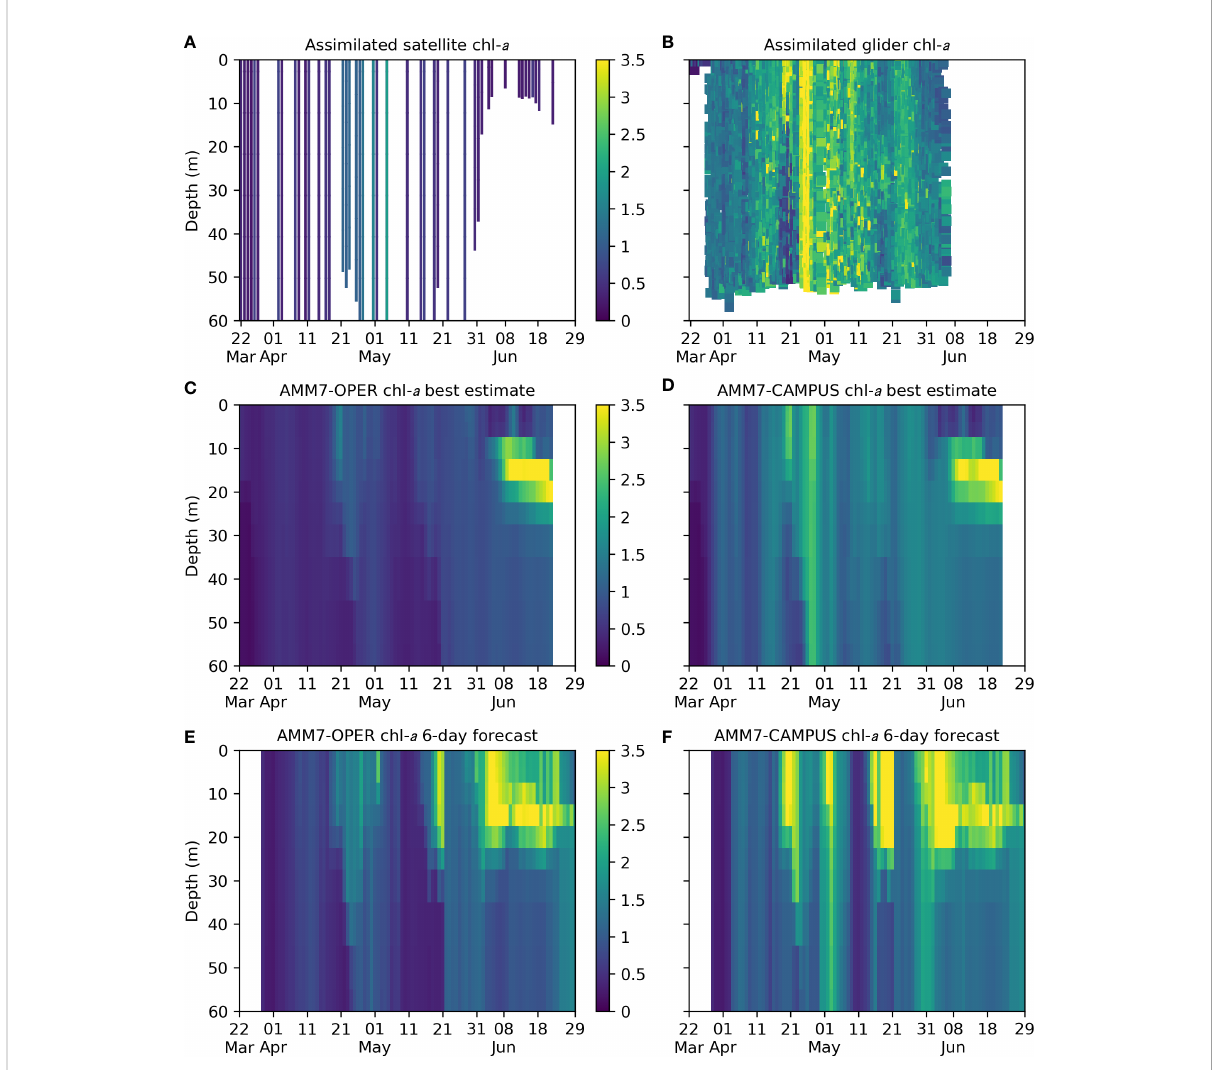
FIGURE 5 Plots of chl- a (mg m -3 ) from (A) assimilated preprocessed satellite data within the glider region plotted to the AMM7-CAMPUS mixed layer depth, (B) assimilated preprocessed glider data, (C) AMM7-OPER best estimate averaged over the glider region, (D) AMM7-CAMPUS best estimate averaged over the glider region, (E) AMM7-OPER six-day forecast averaged over the glider region, (F) AMM7-CAMPUS six-day forecast averaged over the glider